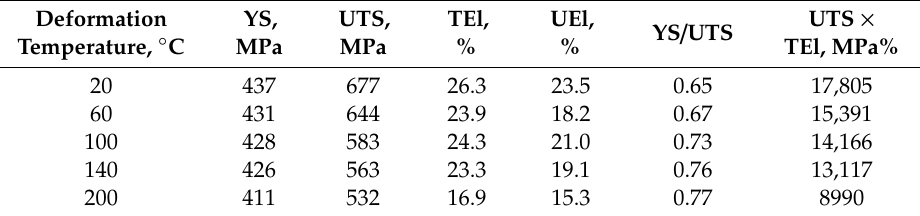
Table 2. Tensile test results of the investigated alloy at di ff erent deformation temperatures. Deformation YS, Temperature, ◦ C